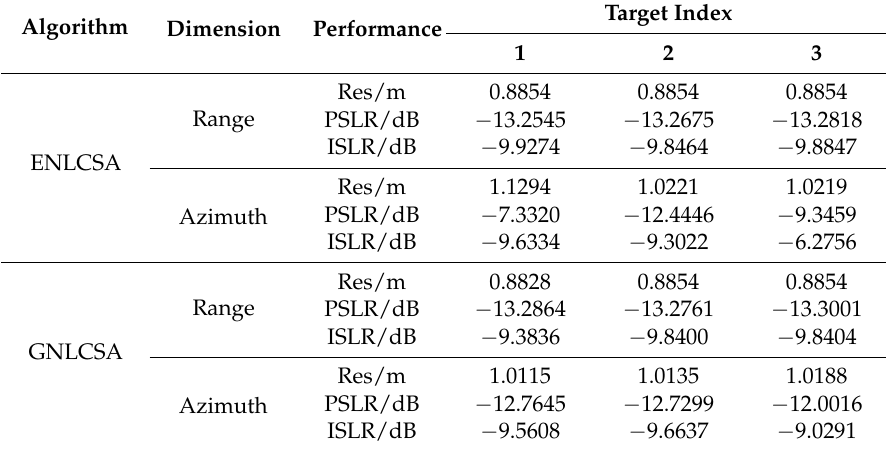
Table 4. Focusing performances for ENLCSA or GNLCSA.